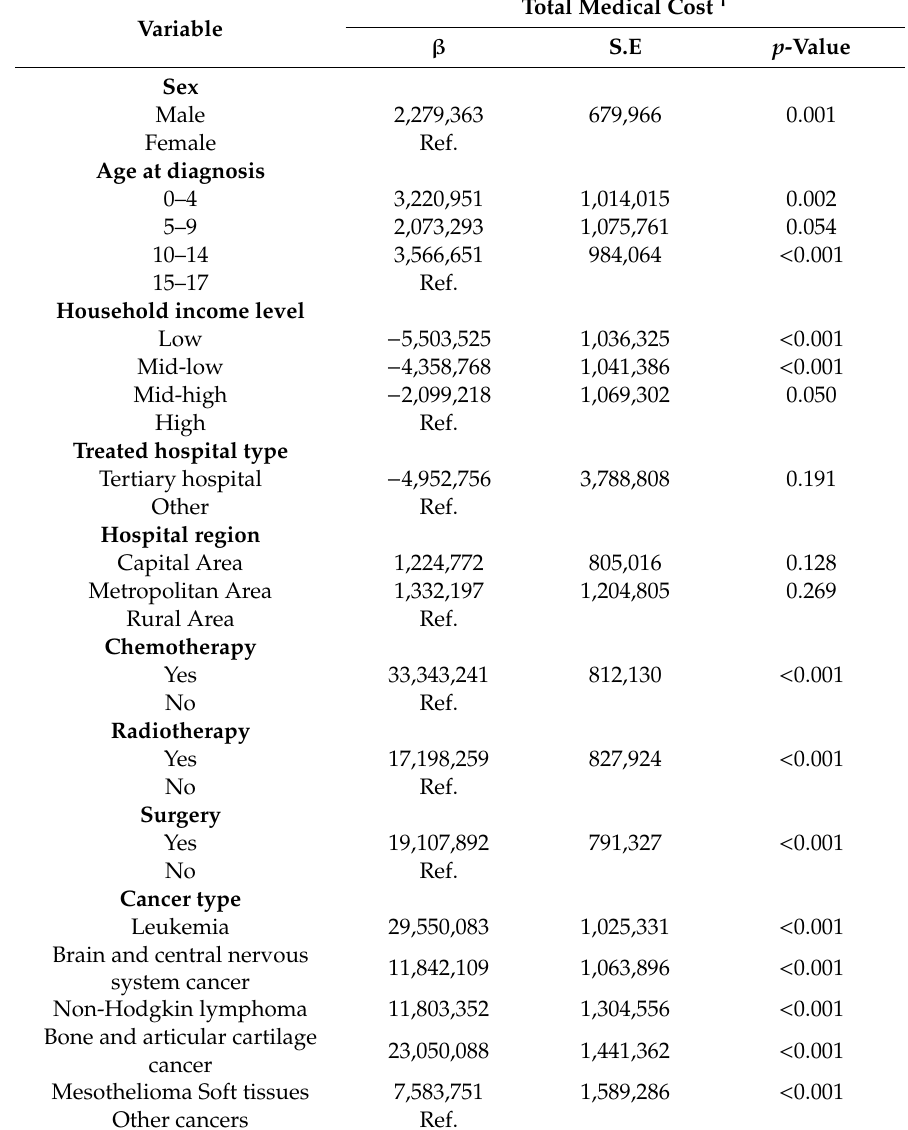
Table 3. Result of regression analysis on the total medical costs to childhood cancer